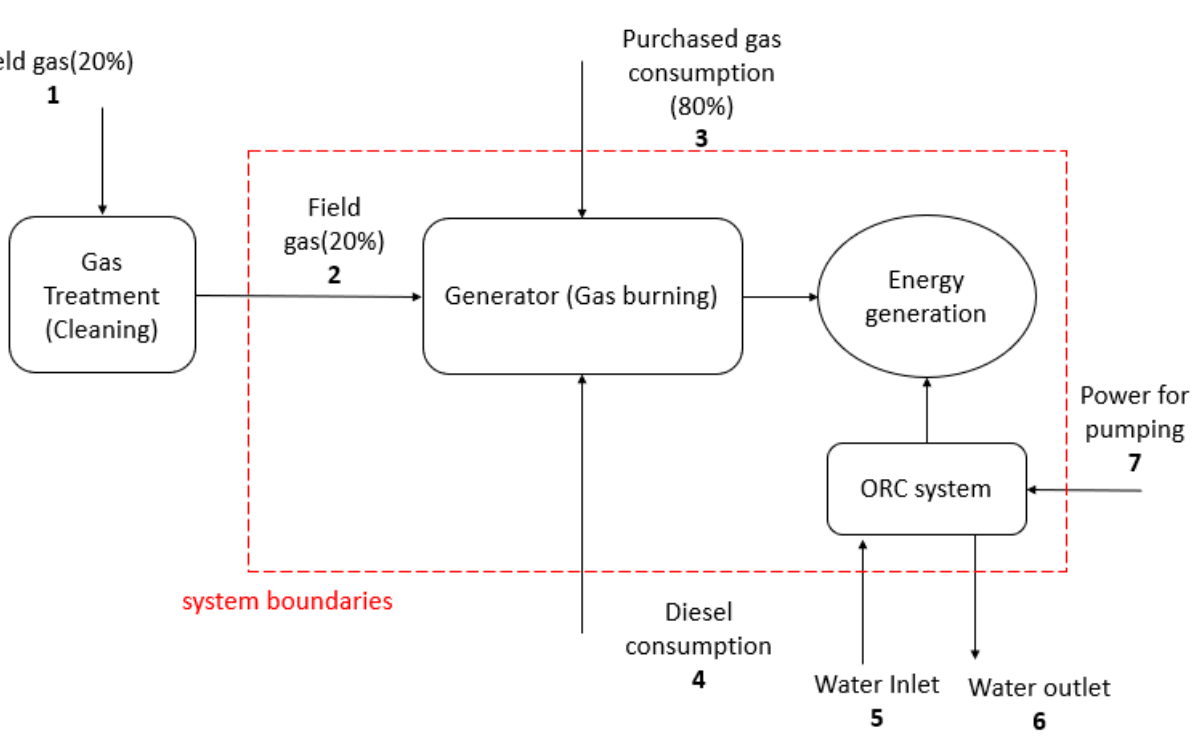
Figure 8. Energy production from the geothermal energy co-generation systems for both the OFA and OFB fields.